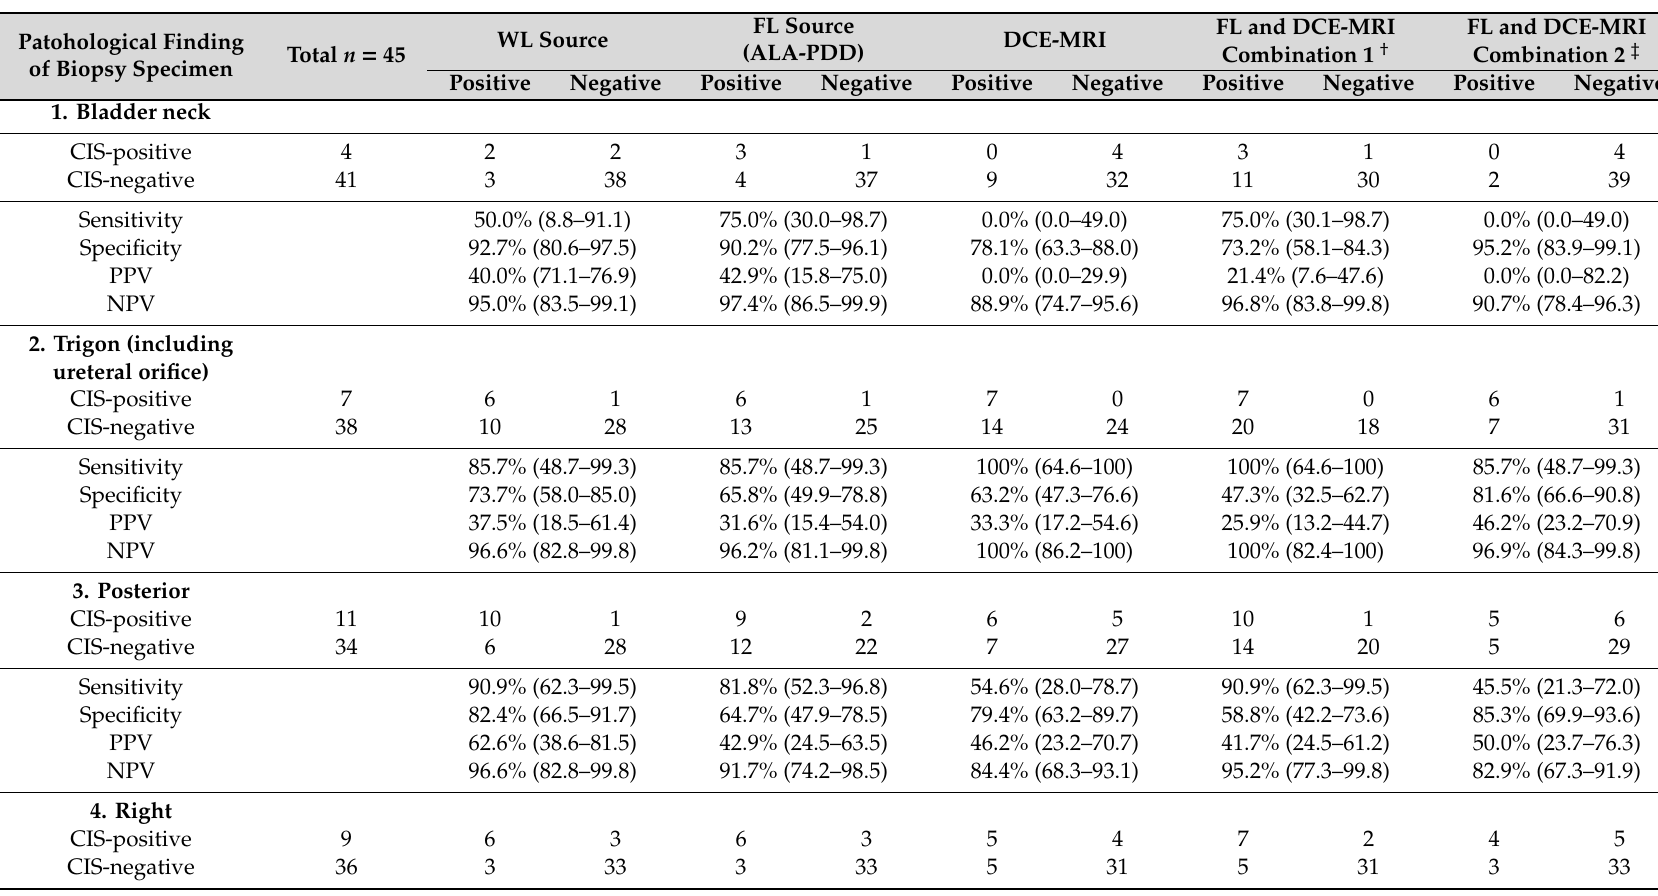
Table 2. The detection accuracy for bladder CIS for the eight bladder segmentations in 45 patients undergoing PDD-TURBT for suspected